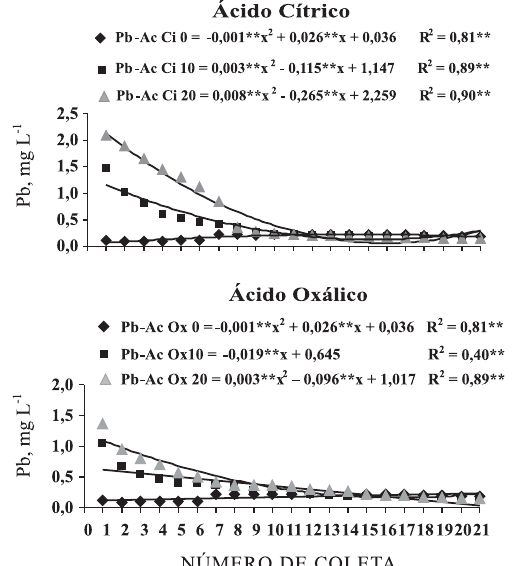
Figura 2. Concentração de Pb em função da aplica- ção das doses (0, 10 e 20 mmol kg -1 ) dos quelantes ácidos cítrico (AC) e oxálico